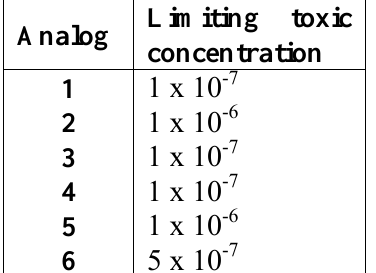
Table 1. Limiting toxic concentration for malachite green